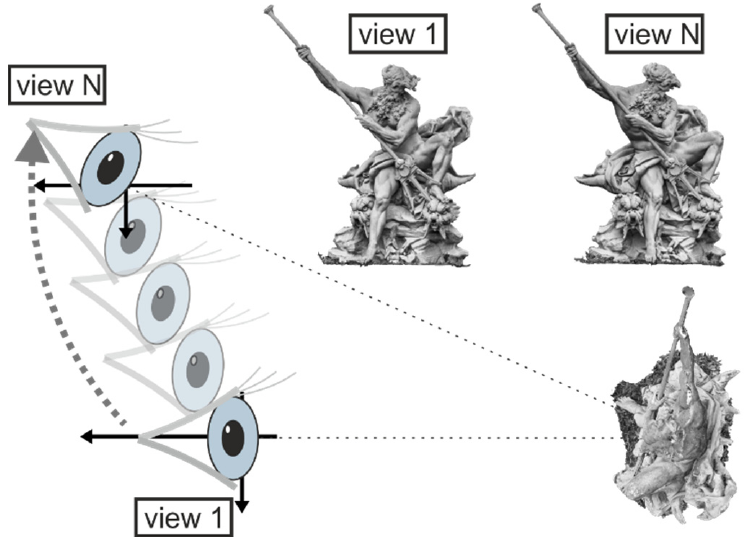
Figure 1. Illustration of viewpoint change.